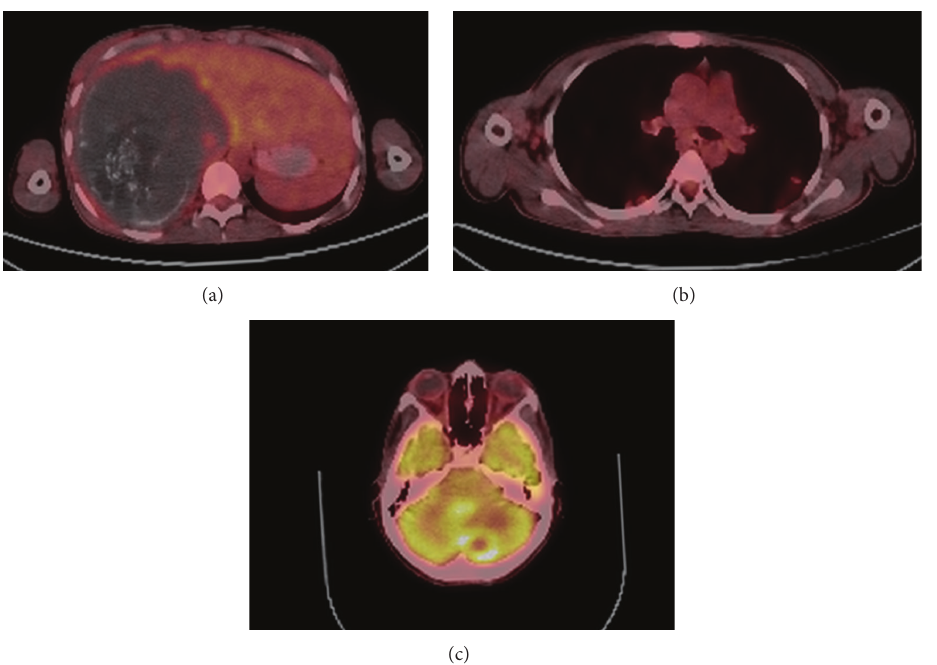
Figure 5: Whole-body PET-CT scan of the second case. AE lesion of the liver with only perilesional 18 F-FDG uptake was seen on fused image (a). The evaluation of pulmonary nodules with PET-CT showed minimally increased metabolic activity (b). An axial slice from cerebellum revealed focal increased FDG uptake in the peripheral zone of the lesion (c).